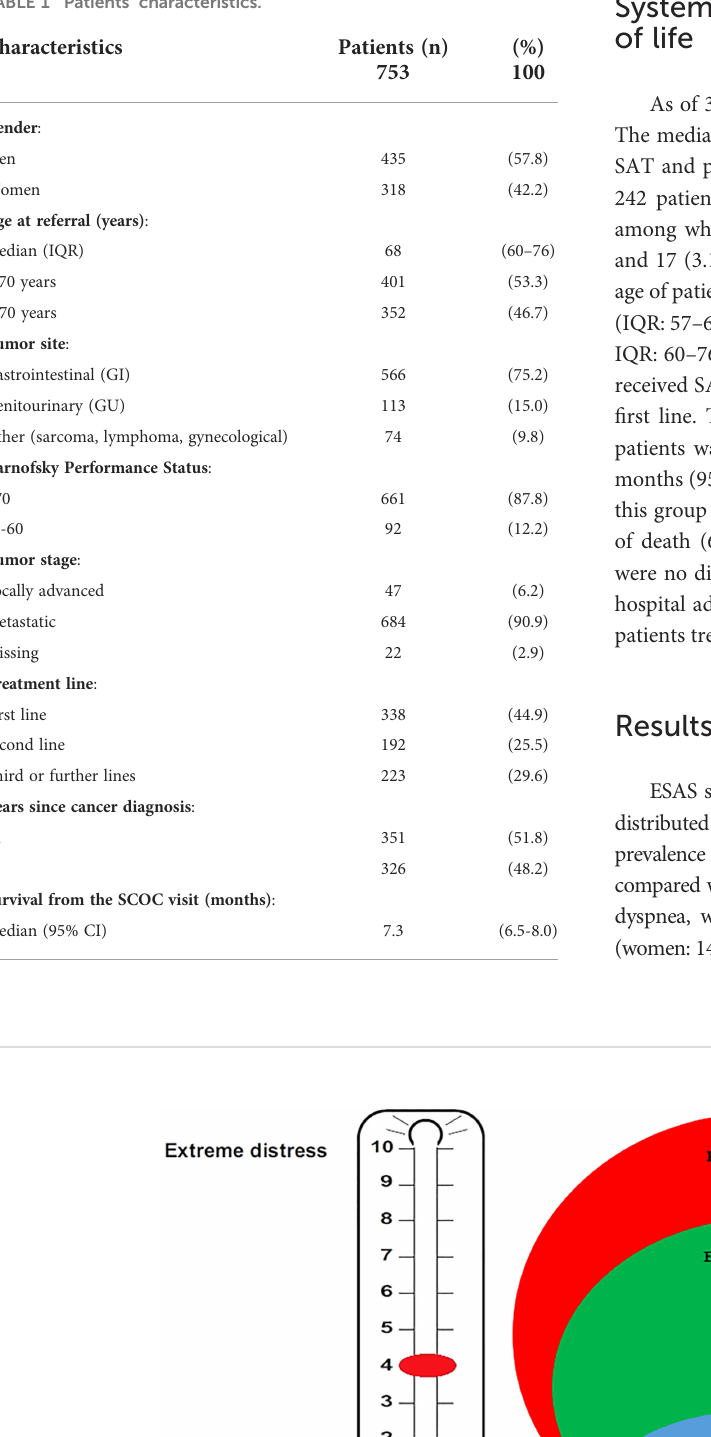
TABLE 1 Patients ’